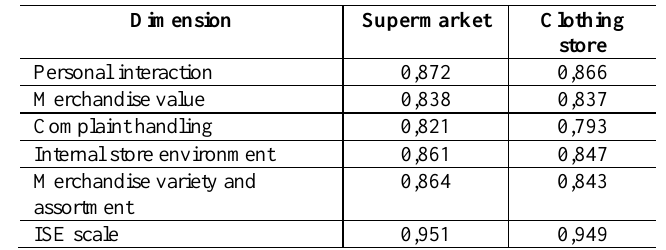
Table 1: Reliability results: cronbach alpha co-efficients